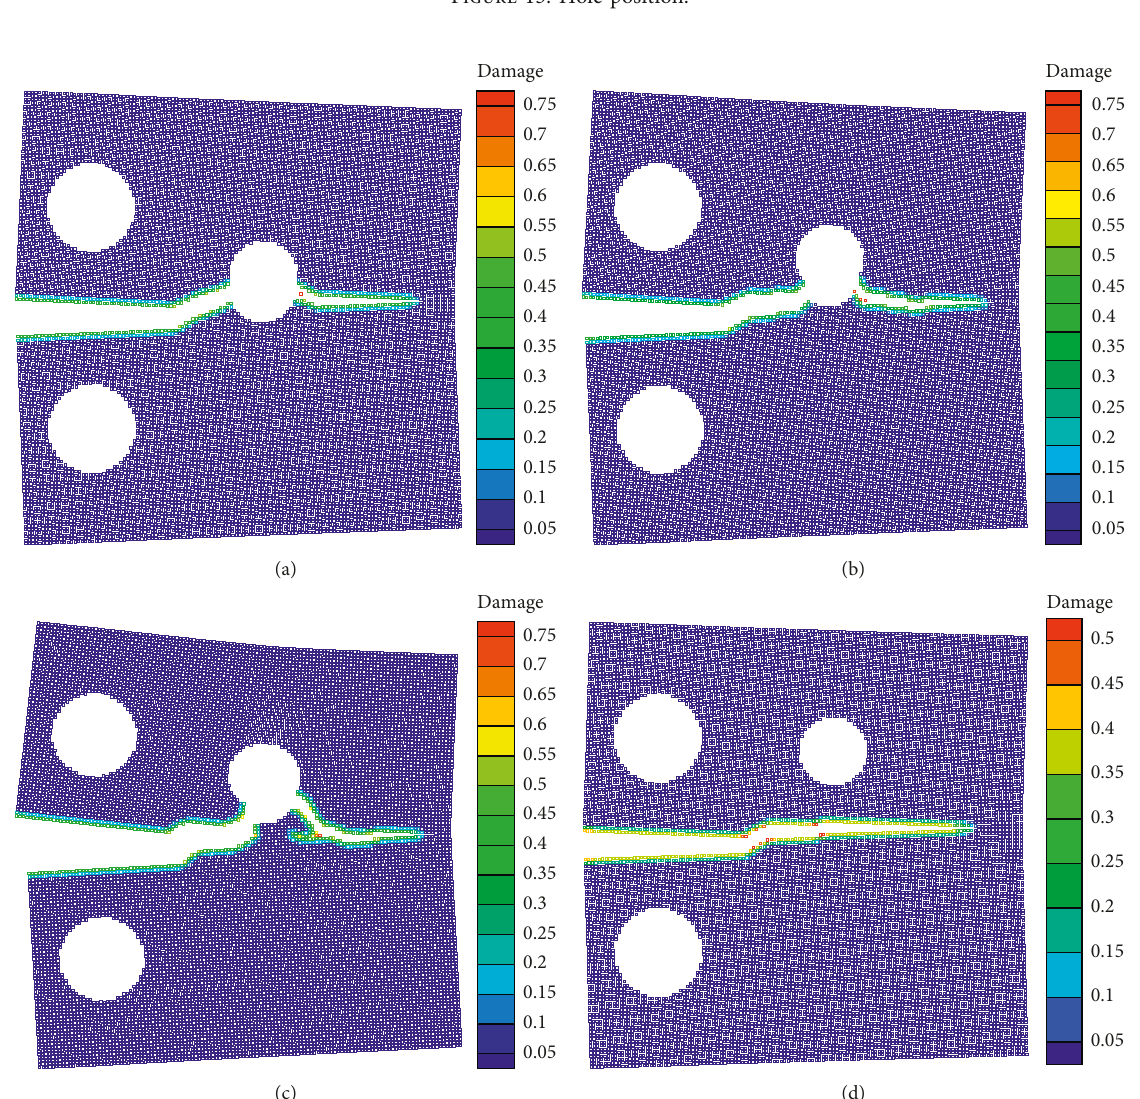
Figure 16: Crack paths with different hole vertical positions when x � 25 mm and (a) y � 10 mm, (b) y � 15 mm, (c) y � 20 mm, and (d) y � 25